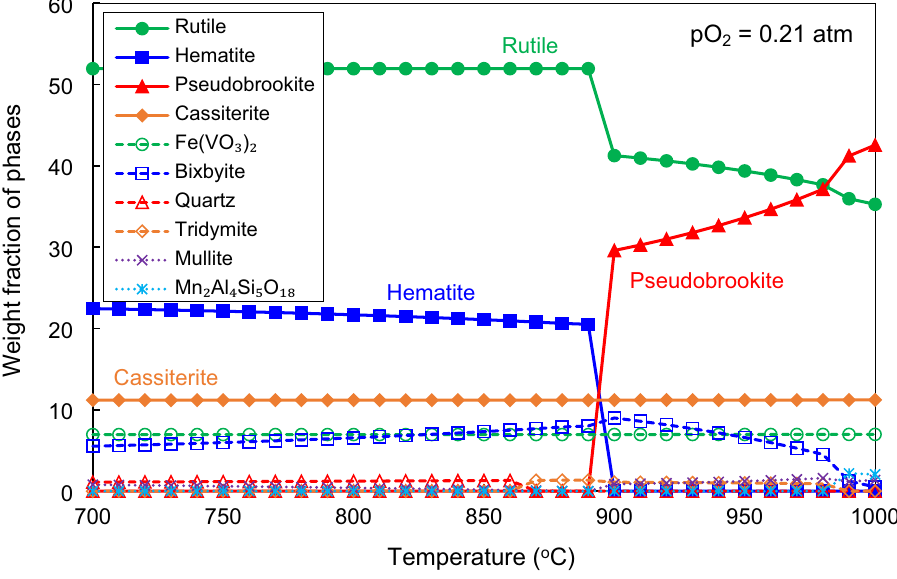
Figure 3. Thermodynamic calculation of the stability of phases as a function of temperature during the pre- oxidation of ilmenite concentrate in air atmosphere.